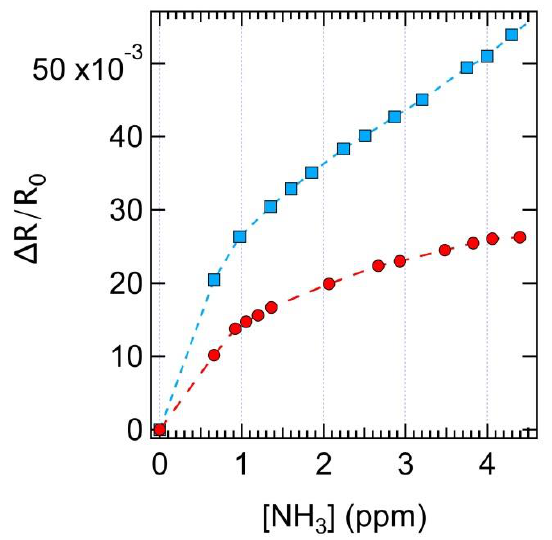
Figure 6. Response ∆ R / R 0 of the SWCNT layer as chemiresistor in dark conditions (red circles) and under white light illumination (blue squares). NH 3 exposure in the 0.6–4.5 ppm range. Dashed lines are drawn as a guide for the eye. All data were collected in the testing chamber.